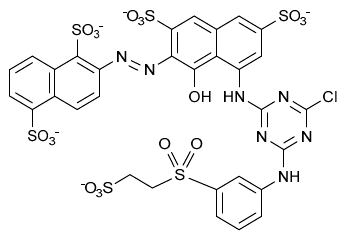
Figure 8. Reactive Red 195 structure.